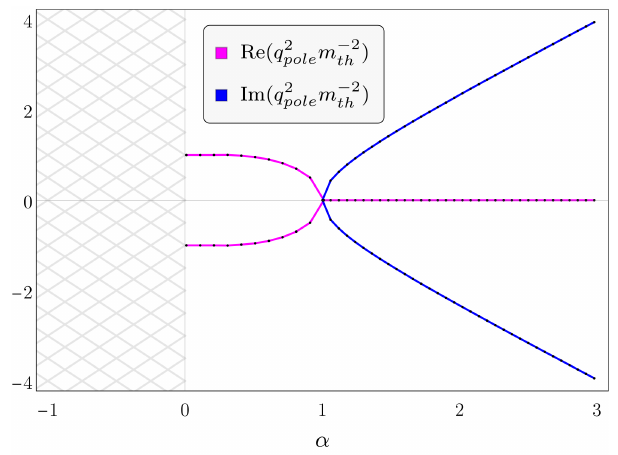
Figure 17 . Poles of the propagator (6.1) as a function of α . For α < 0 there are no additional poles, beyond the massless one. For 0 < α < 1 there are two stable ghost poles, and one of them is a tachyonic ghost. Finally, for all α > 1 there is a pair of massless complex-conjugates